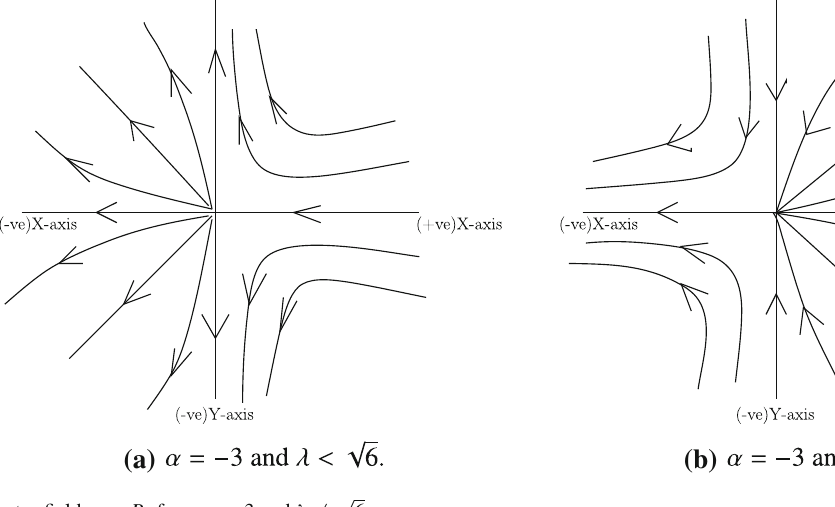
Fig. 3 Vector field near P 2 for α = − 3 and λ (cid:6)=